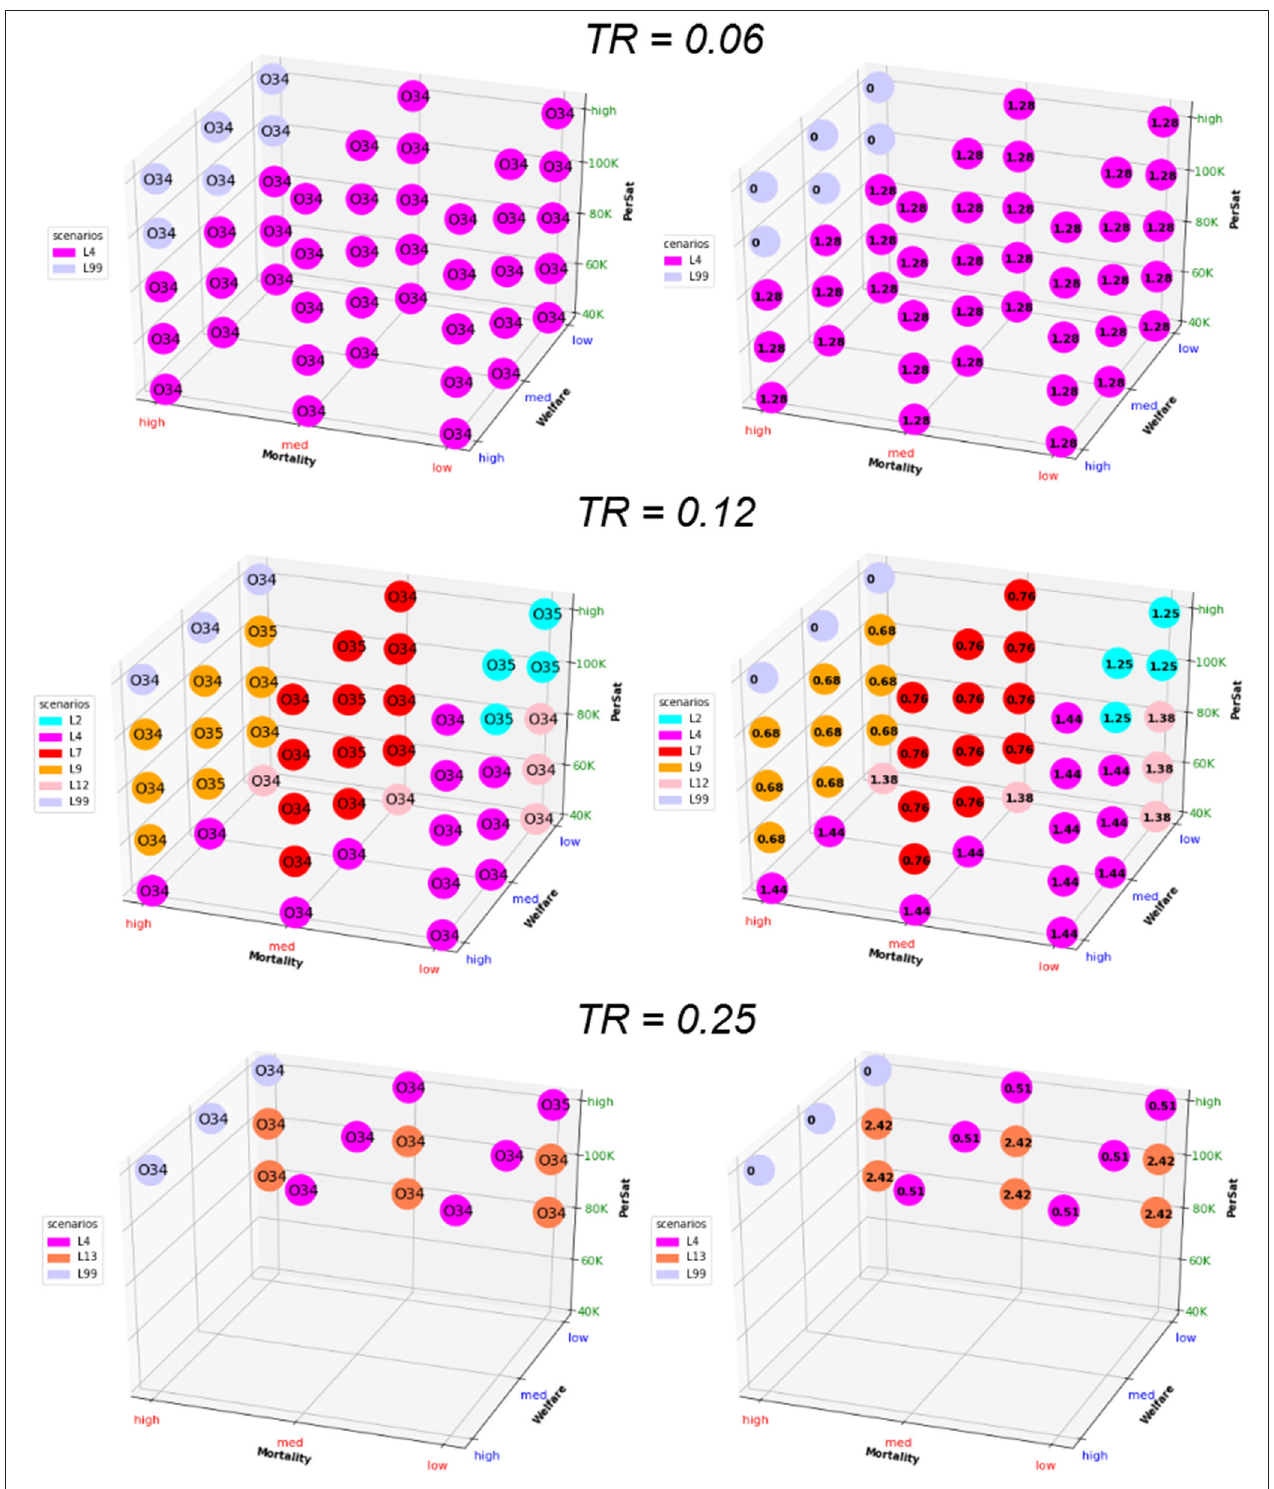
FIGURE 6 | Graphical representation of the optimal solution depending on the strength of the constraint for a whole period of 600 days. The results in the right column are expressed as direct cost (in billion euros); Tr, transmission rate. The optimal solution that minimizes the overall economic impact under a set of constraints is found in the foreground (low mortality, high welfare, and low